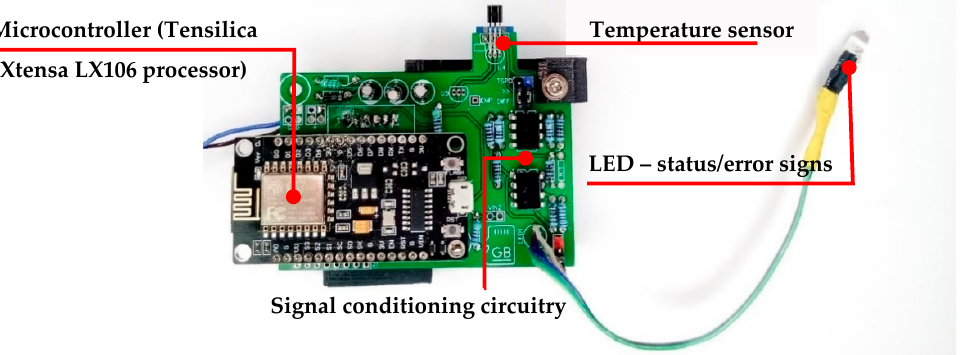
Figure 6. Prototype hardware for the real-time measurement of surface solar radiation.